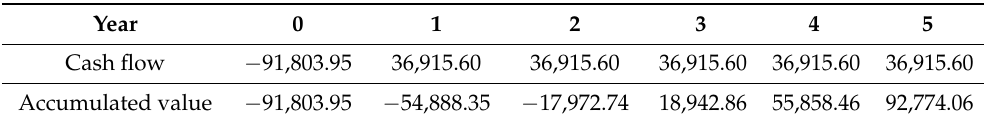
Table 4. Annual cash flow for the lipid material and simple payback analysis.